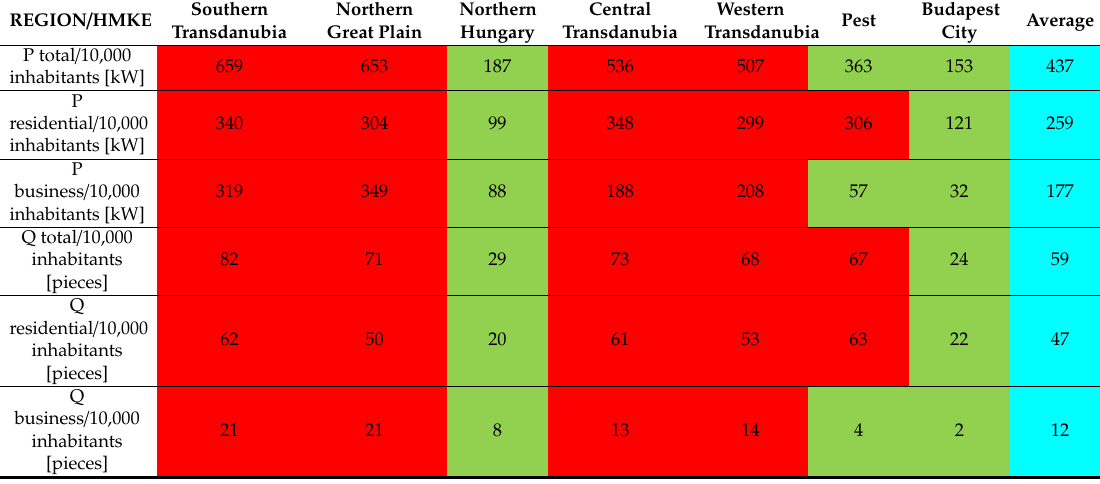
Table 5. HMKE figures relative to population size in the seven examined regions of Hungary (red: above the average, green: under the average, blue: average).